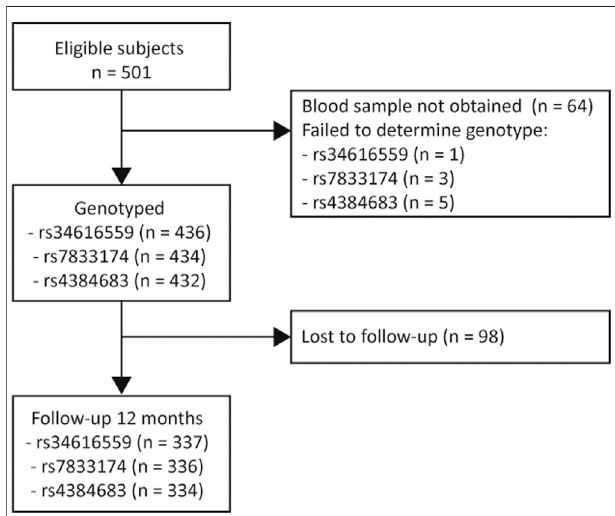
FIGURE 1 | Study fl owchart. A total of 334 – 338 (depending on the different SNPs) was included in the fi nal analysis.